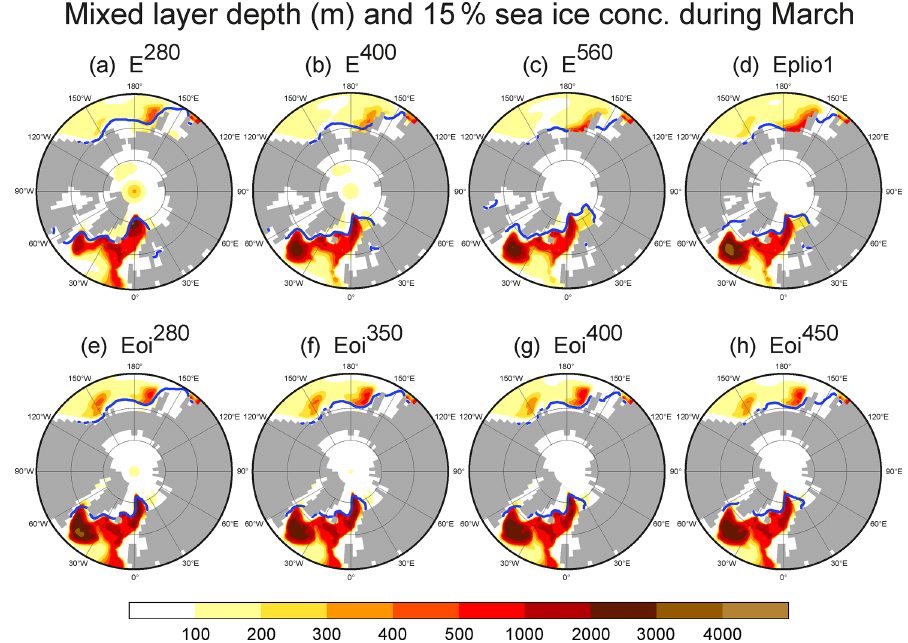
Figure 9. Oceanic mixed layer depth in the Northern Hemisphere during March. The blue lines indicate the extent of 15% sea ice concen- tration. For a comparison of PlioMIP1 and PlioMIP2, see (d, g) . For the individual effects of CO 2 and Pliocene boundary conditions, see (b, e) , respectively.